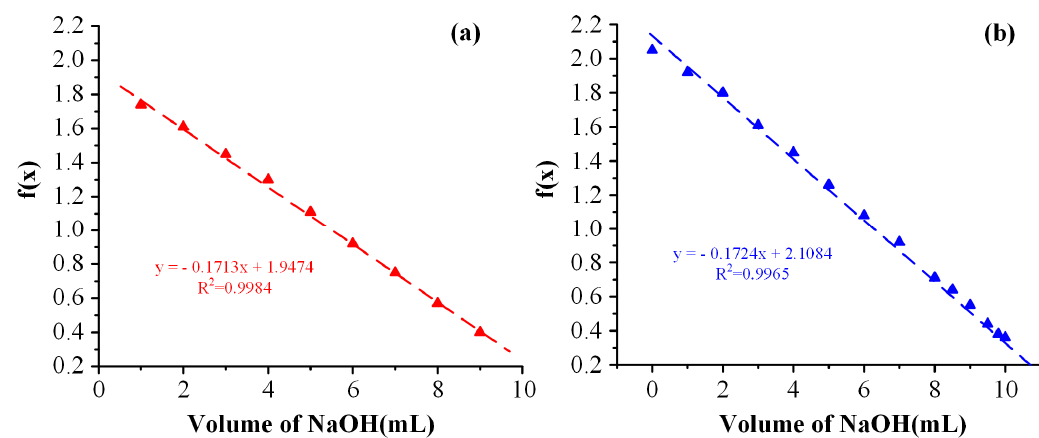
Figure 3. Linear titration curves of CS (a) and Cys-CS (b) used for the estimation of DD.